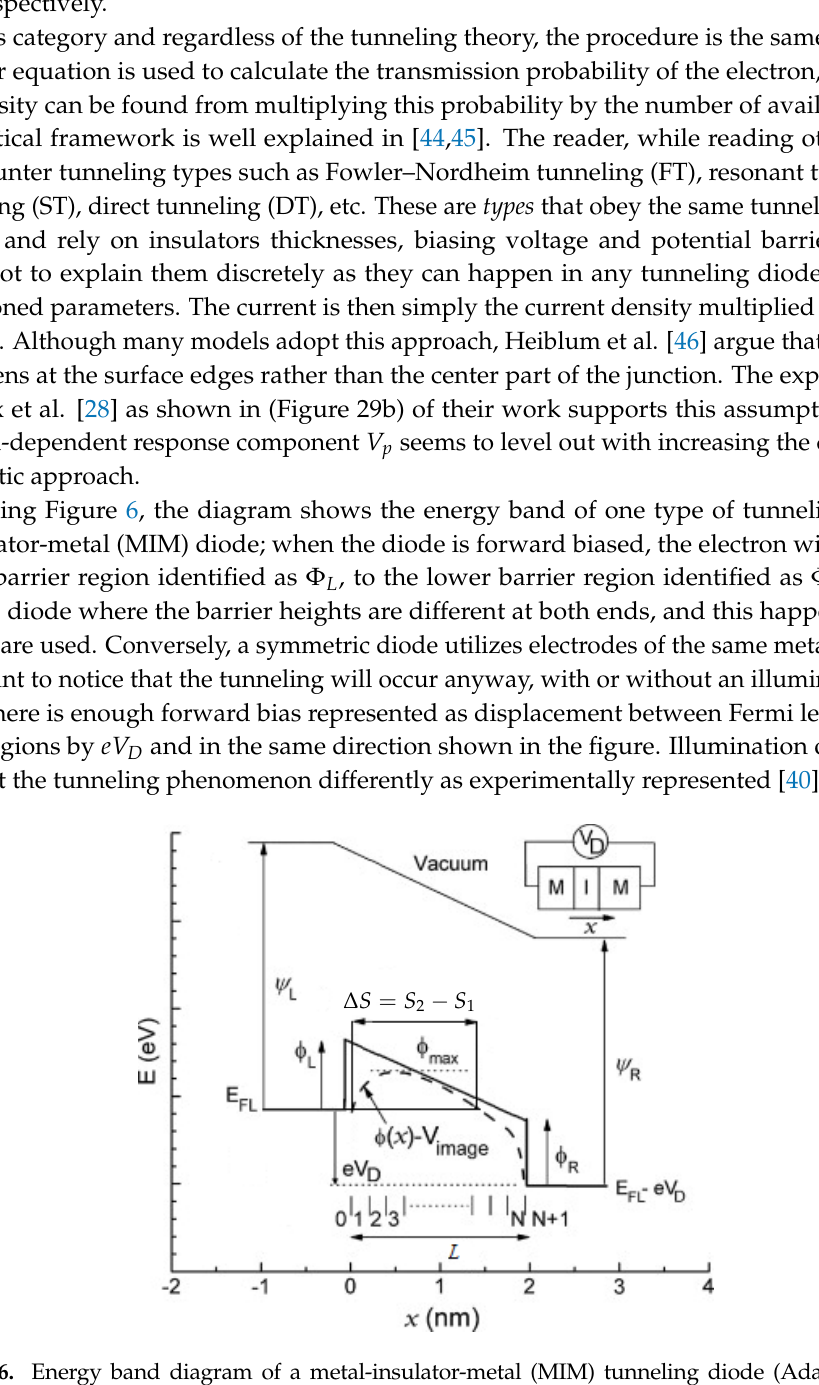
Figure 6. Energy band diagram of a metal-insulator-metal (MIM) tunneling diode (Adapted with permission from [47], Springer,